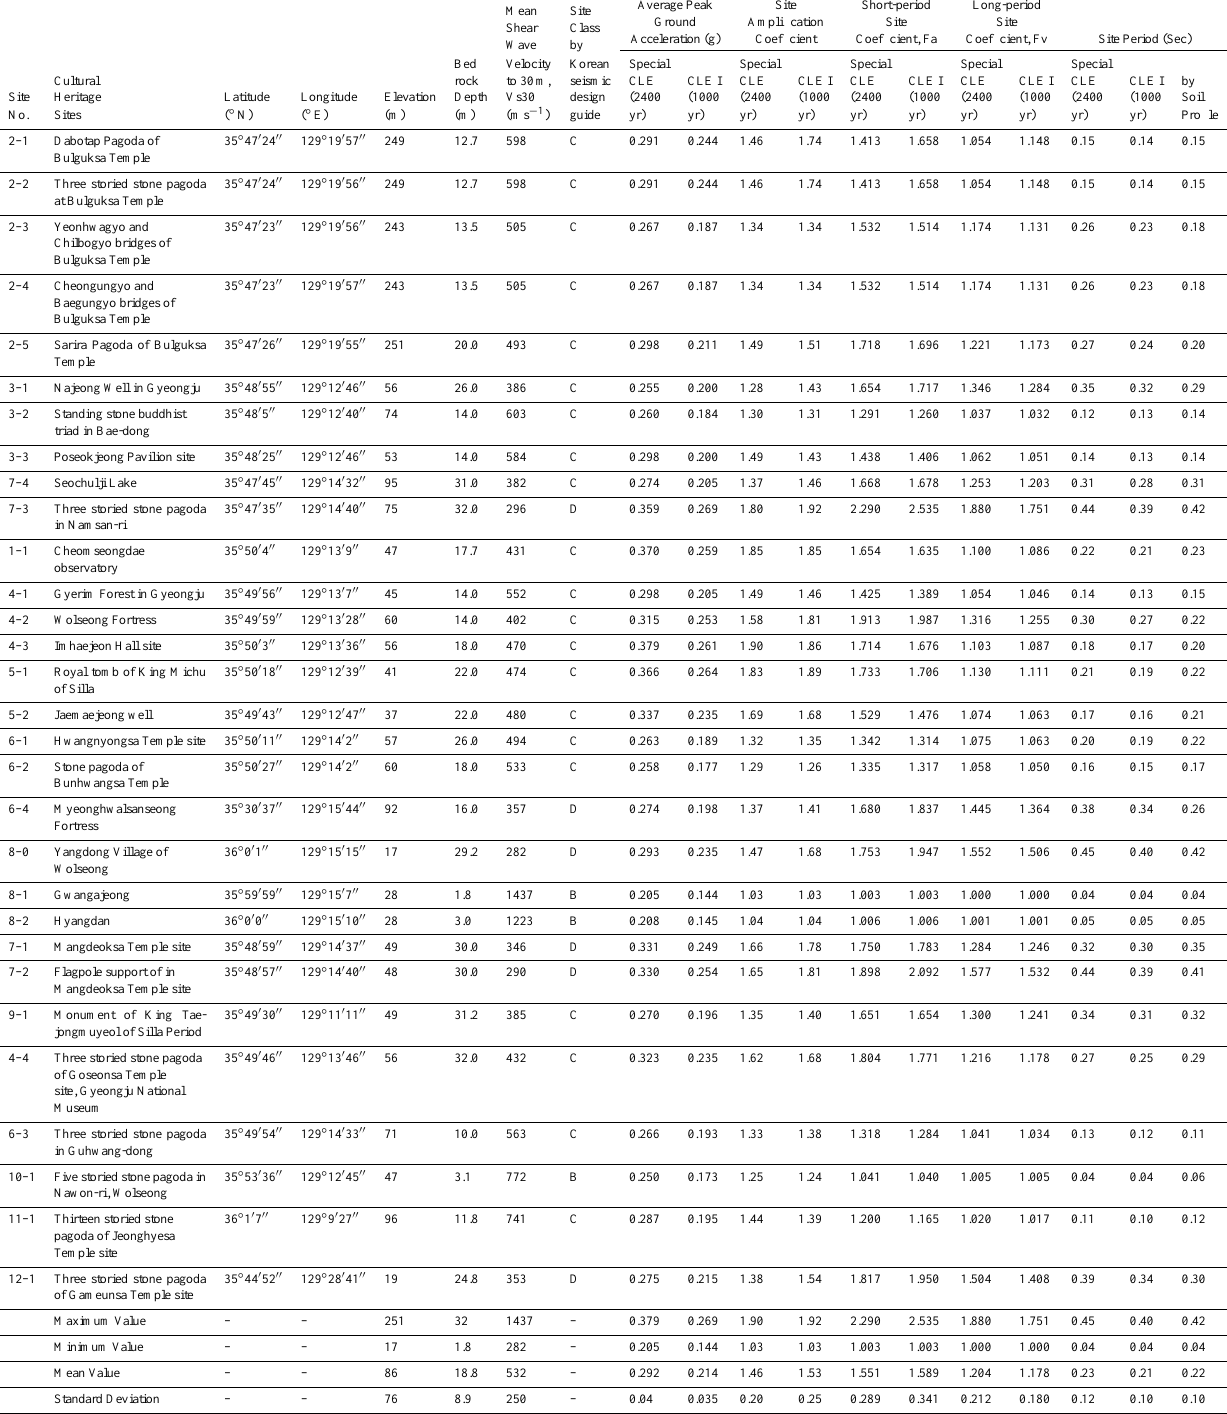
Table 3. The results of site-specific ground response analysis for cultural heritage